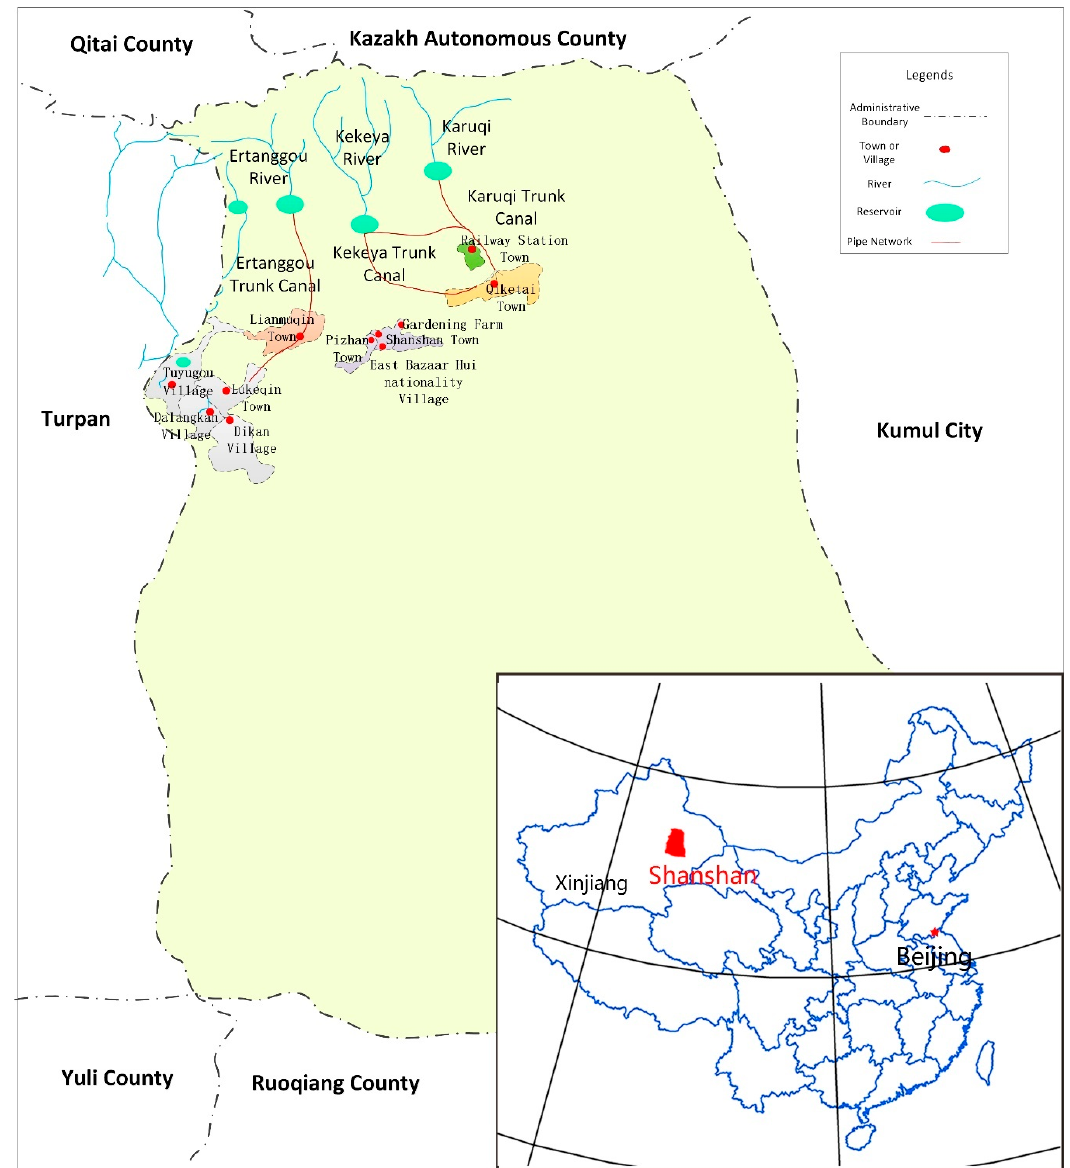
Figure 1. River system of Shanshan County.